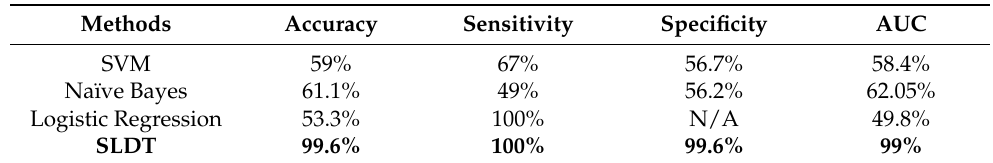
Table 7. Performance measures of the proposed method with other machine learning methods in combined dataset 1 (MC and CHN).